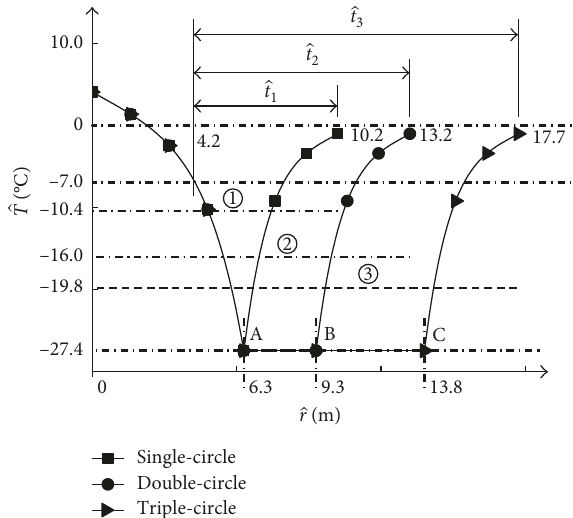
Figure 3: Temperature 􏽢 T as a function of radius for different freezing